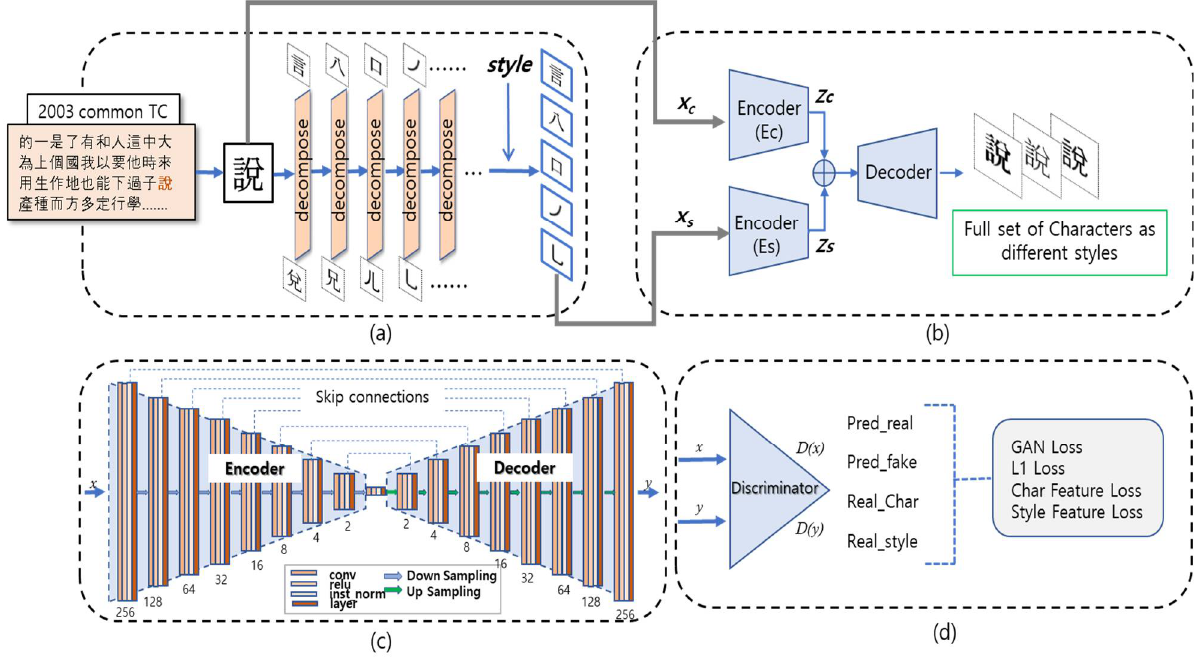
Figure 15. CCFont model data flow diagram. ( a ) CRC Module; ( b ) CCFont Generating Novel Characters Module; ( c ) CCFont Training Module (Generator) and ( d ) CCFont Training Module (Discriminator).